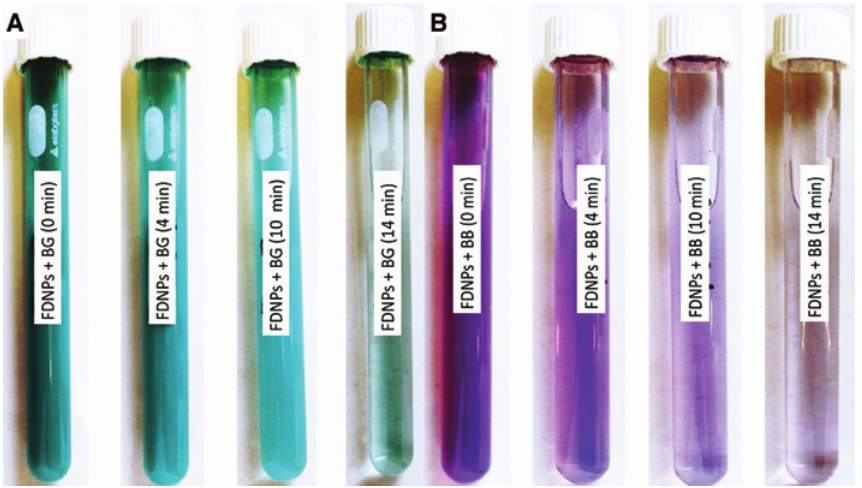
Figure 5: Foliar doped nanoparticles triggered achromatization in (A) bromocresol green and (B) bromophenol blue upon direct solar